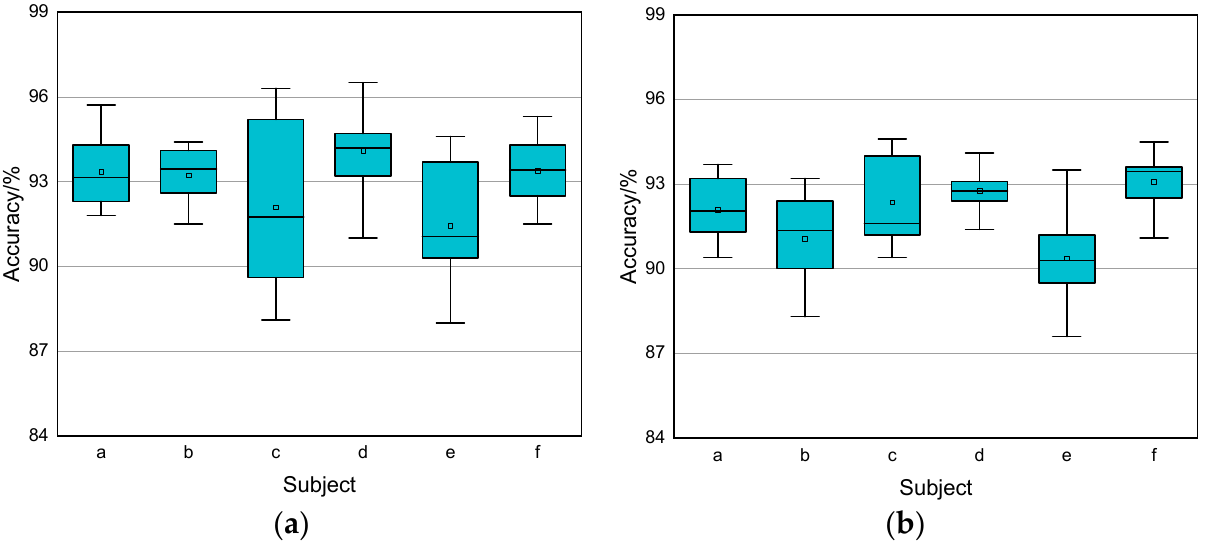
Figure 9. ( a ) Box plot diagrams for six known experimental subjects; ( b ) box plots for the six unknown experimental